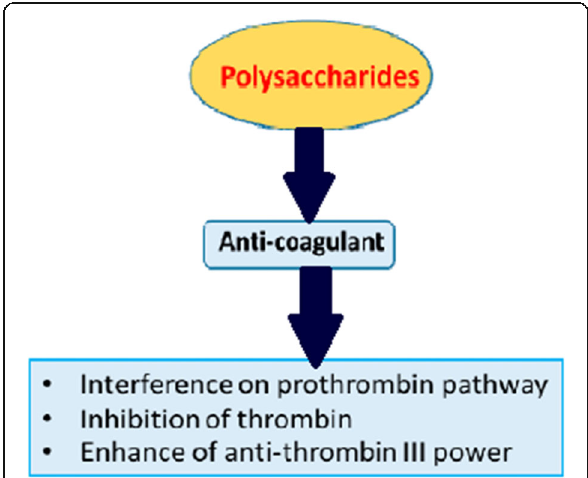
Fig. 3 Mechanism of anticoagulant activity of marine